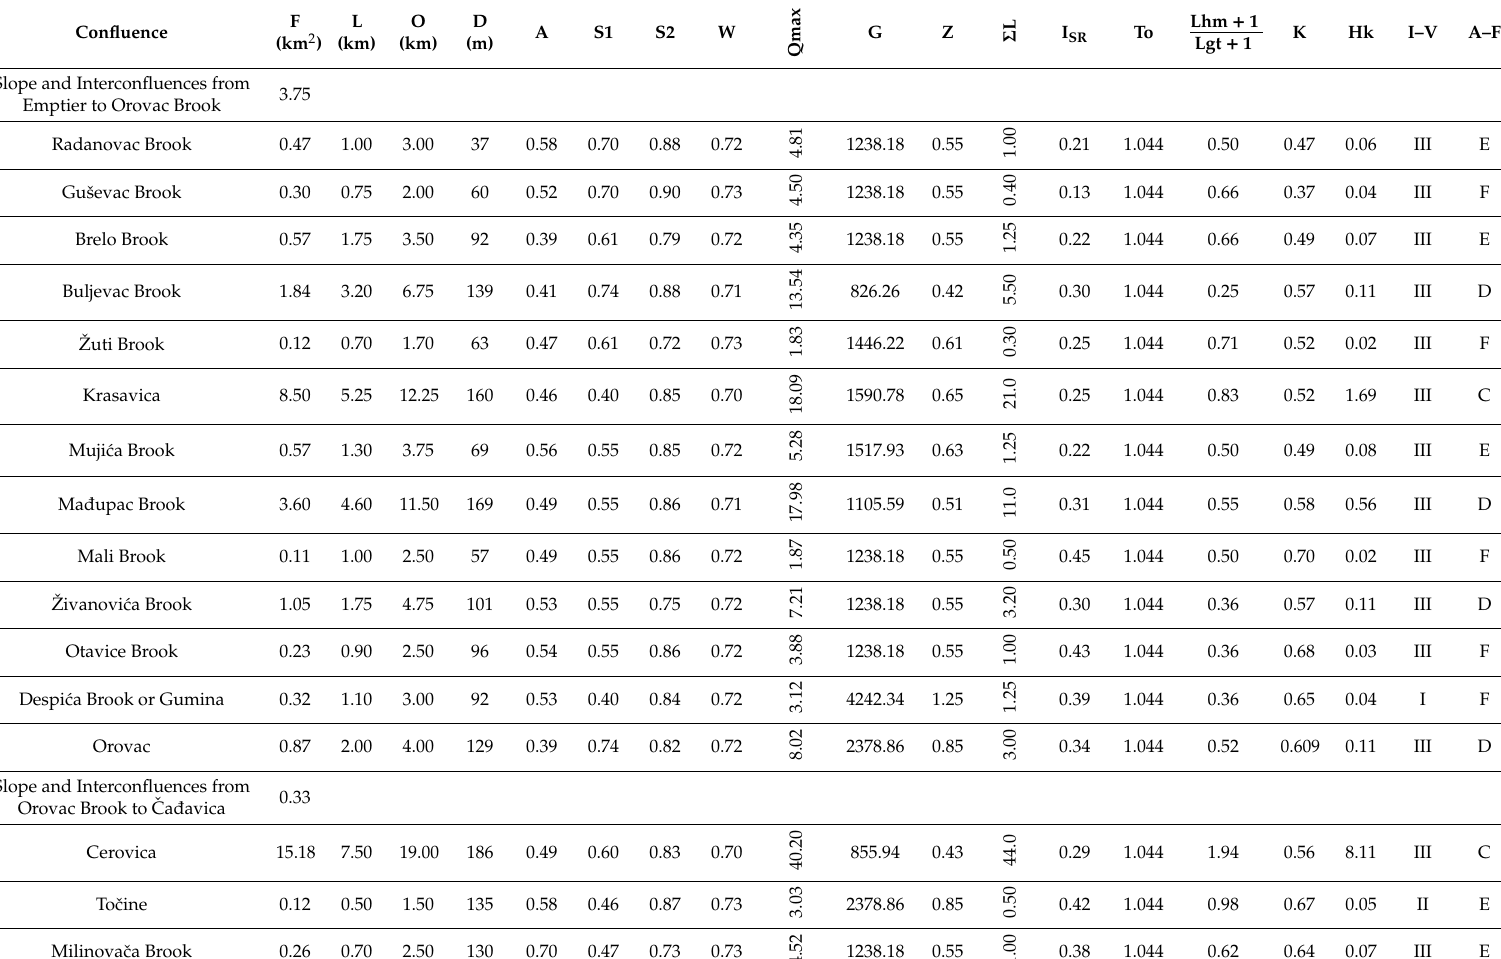
Table 3. Quantitative indicators of torrential streams in the Likodra river